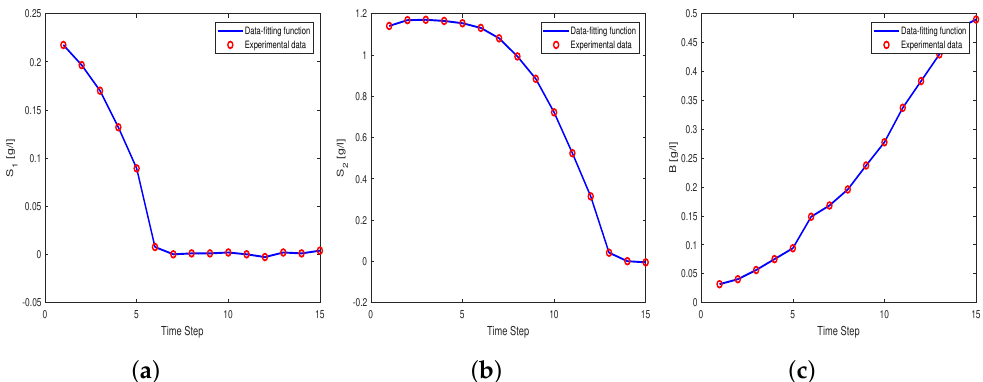
Figure 3. ( a ) trajectory of substrate S 1 using data-fitting function with a solid line and experimental data with a circle. ( b ) The trajectory of substrate S 2 . ( c ) The trajectory of Biomass B